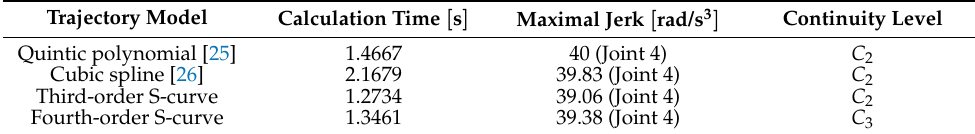
Table 4. Comparison of the results of multiple trajectory planning